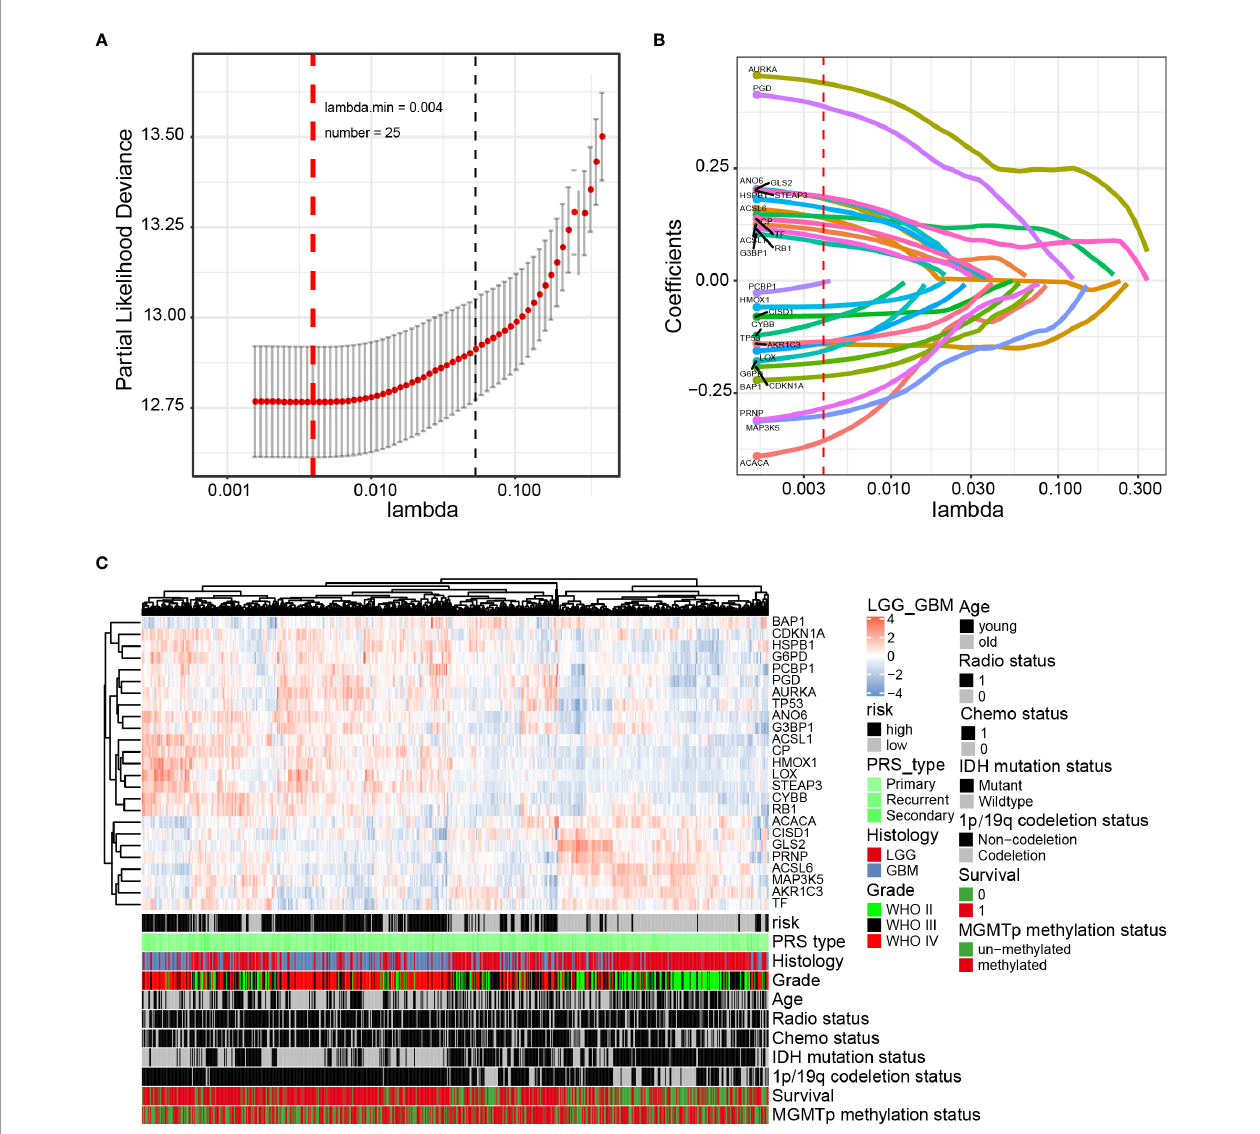
FIGURE 2 | Identi fi cation of a 25-gene risk signature for overall survival by LASSO regression analysis in CGGA cohort. (A) Cross-validation for tuning parameter selection in the proportional hazards model. (B) LASSO coef fi cient spectrum of 25 genes in gliomas. (C) Heatmap shows the association of risk and clinic pathological features based on the 25-gene risk signature. LASSO, least absolute shrinkage and selection operator.